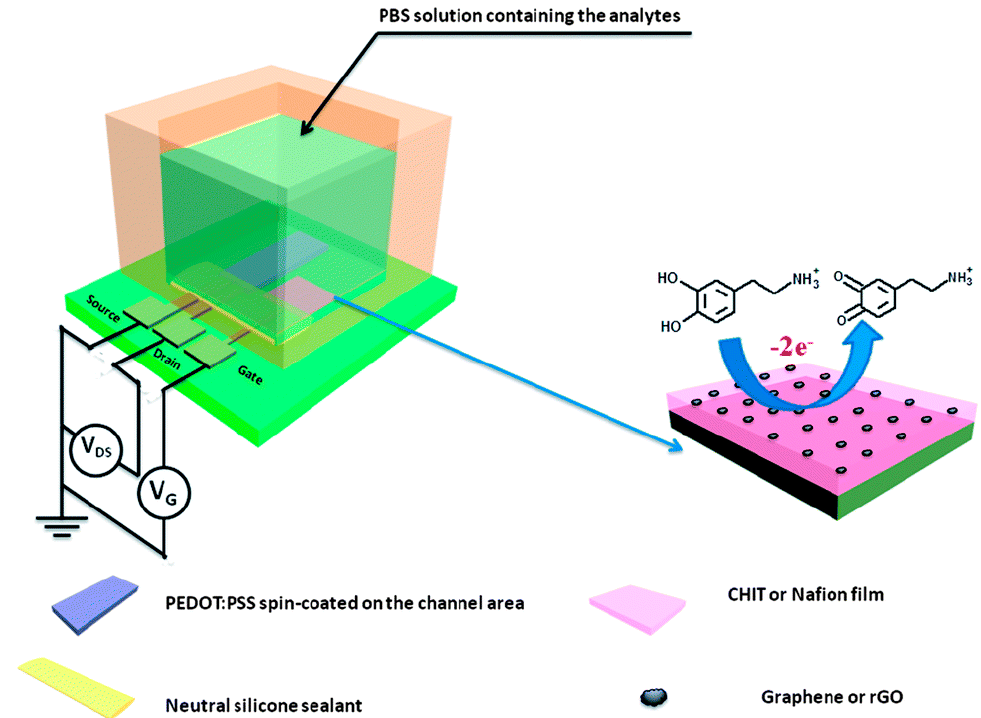
Figure 3. Schematic diagram of an OECT-based (organic electrochemical transistors) dopamine sensor modified with Nafion (CHIT) and graphene (rGO) flakes on the Pt gate electrode. The electro-oxidation of dopamine occurs on the surface of the gate (right figure) [50]. Copyright 2014, Royal Society of Chemistry.